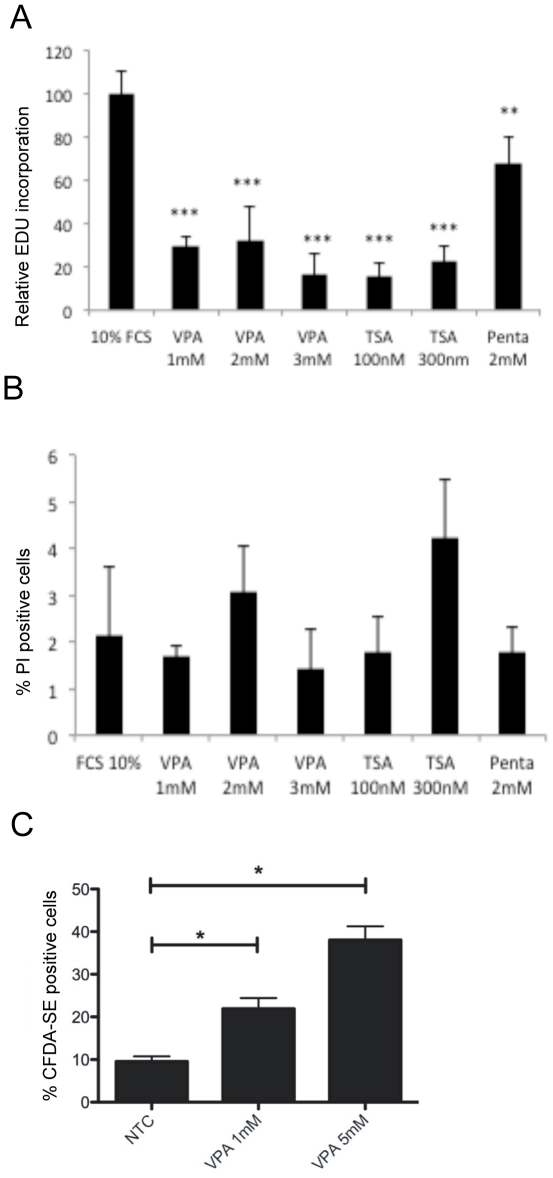
Effect of VPA on human pericyte proliferation and cell viability.(A) Proliferation rate i.e. % of cells entering S-phase depicted by EDU incorporation in pericytes exposed to VPA, TSA or Penta for 24 hours compared to NTC pericytes (100%). (B) Cell viability i.e. % of cells positive for PI in pericytes exposed to VPA, TSA or Penta for 24 hours compared to NTC pericytes. (C) Flow cytometric analysis of CFDA-SE labeled pericytes exposed to 1 and 5 mM of VPA for 7 days compared to NTC. CFDA-SE retention reflects a lower rate of proliferation in pericytes. Mean ± SD, in A and C n = 6, in B n = 4. T-test * p<0.05, ** p<0.01, *** p<0.001.